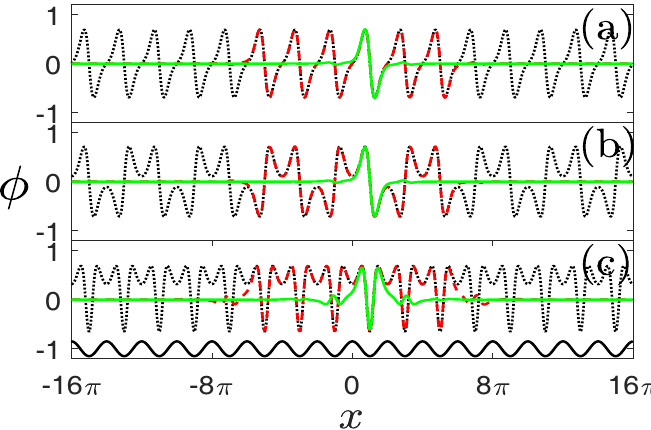
Figure 5. Nonlinear Bloch waves originating from the centers ( a , c ) and edge ( b ) of the BZ and FGSs in the second ( a , b ) and third ( c ) gaps. Dotted (black), solid (green), and dashed (red) lines stand for NLBWs, FGS, and truncated-Bloch-wave solitons, respectively. ( a ) N = 1.1066; ( b ) N = 1.2411; ( c ) N = 1.5319; b = 0.4 in ( a , b ) and 1.1 in ( c ). The solid curve at the bottom of ( c ) denotes the distribution of a lattice. α = 1.6 and p = 1.5 in all the